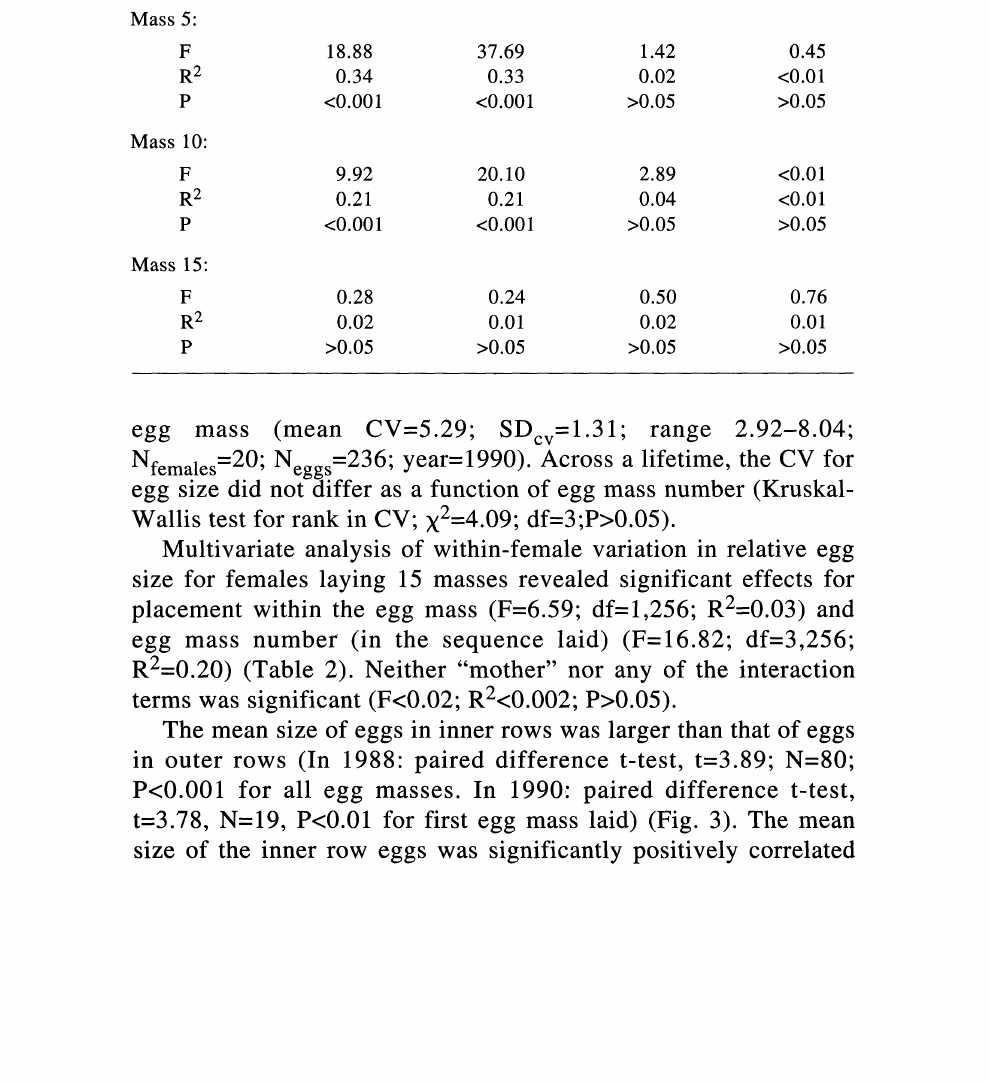
Table 1. Effect of male (mate) and female size on mean egg size as a function of egg mass number in the sequence laid. Male + female; multiple regression (d.f.=2,75). Male (d.f.=l,78), Female (d.f.=l,76): univariate regression. Increment (d.f.=l,75): increase in explained variation due to addition of male size to regres- sion already including female